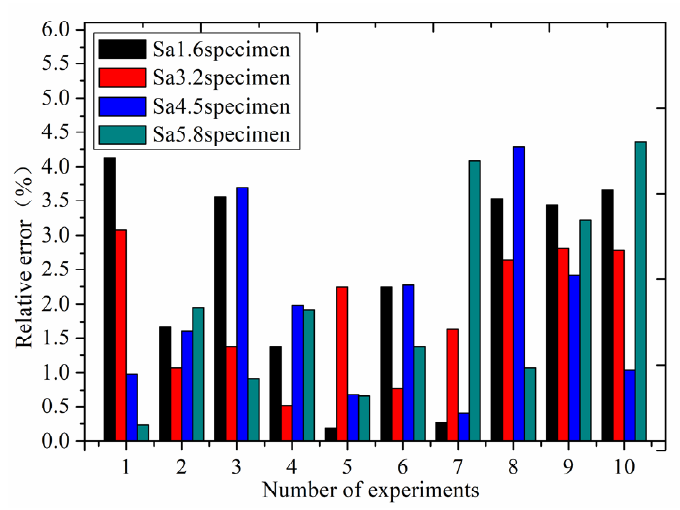
Figure 9. The relative error of ten experiments.